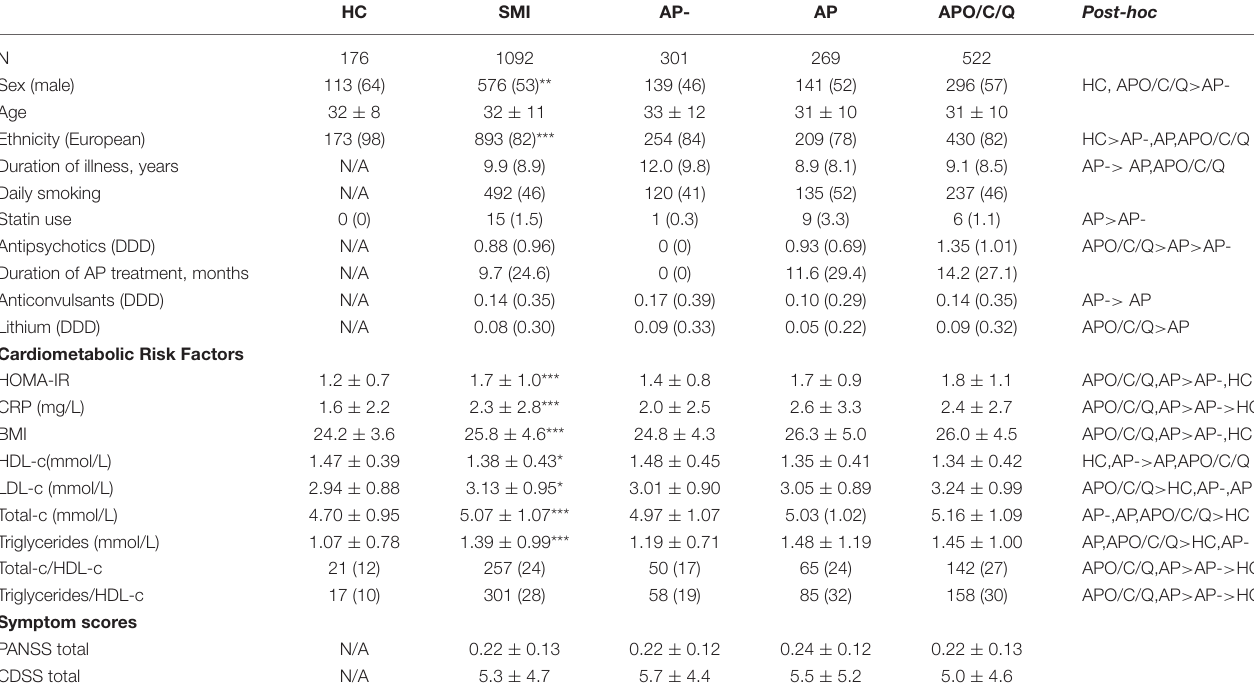
TABLE 1 | Demographics of the study